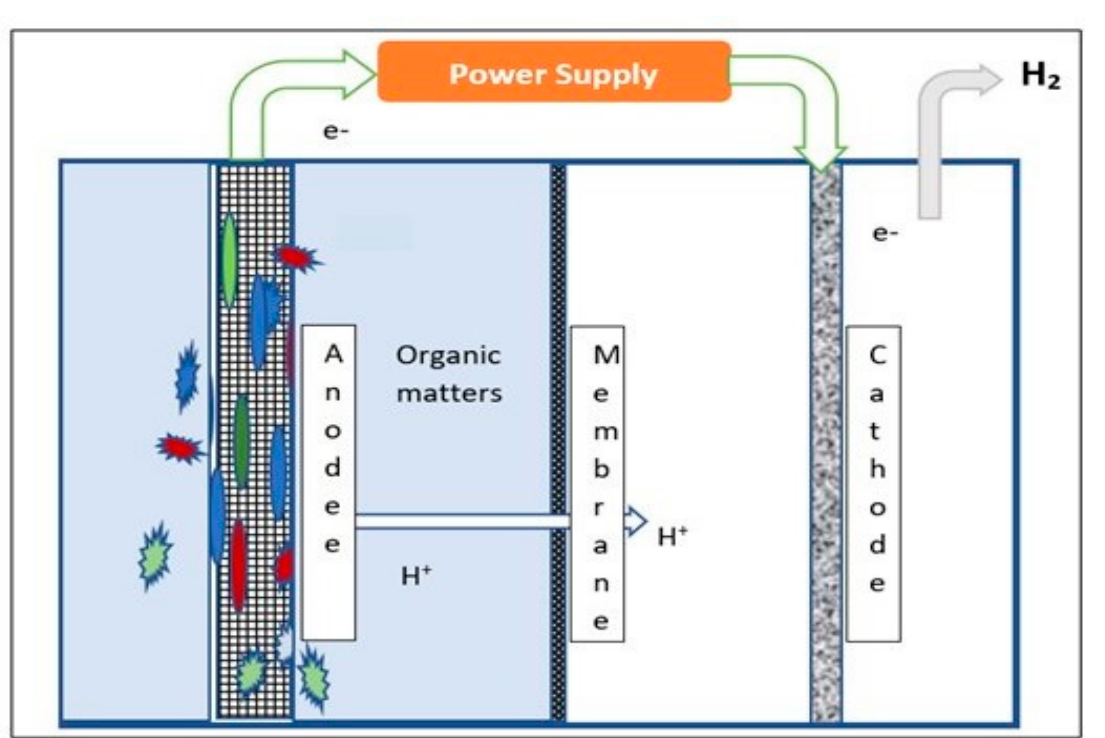
Figure 8. Schematic representation of H 2 production process through MEC. In laboratory settings, MECs produce 1 to 4 L/L/d of hydrogen [91–94]; however, these rates of production have not been observed using real wastewater. Using a six- cassette-style double-chamber MEC, Heidrich et al. reported pure hydrogen production (0.015 L/L/d) using urban wastewater in a small-scale trial at a wastewater treatment plant, along with simultaneous COD reduction (44.5%) [95]. Trials by the same group increased H 2 production to 0.6 L/L/d, using a cassette-type double-chamber MEC at ambient temperature, demonstrating stability for more than 12 months at the wastewater treatment plant with 33% COD reduction [96]. Researchers at the University of Leon reported around 90% COD reduction from both synthetic and municipal wastewater with a membrane-free MEC, but H 2 production rates were relatively low [97,98]. Table 10 shows the application of MEC across a wide range of wastewater sources, highlighting the columbic efficiency, which ultimately drives the hydrogen production rate. COD reduction rates and H 2 production rates vary significantly, depending on the effluent source and particular reactor configuration, demonstrating the challenge in developing technology to attain both hydrogen production and good-quality water treatment. However, with systems optimised specifically for H 2 production, in which the external bias is carefully controlled, greater H 2 production yields are